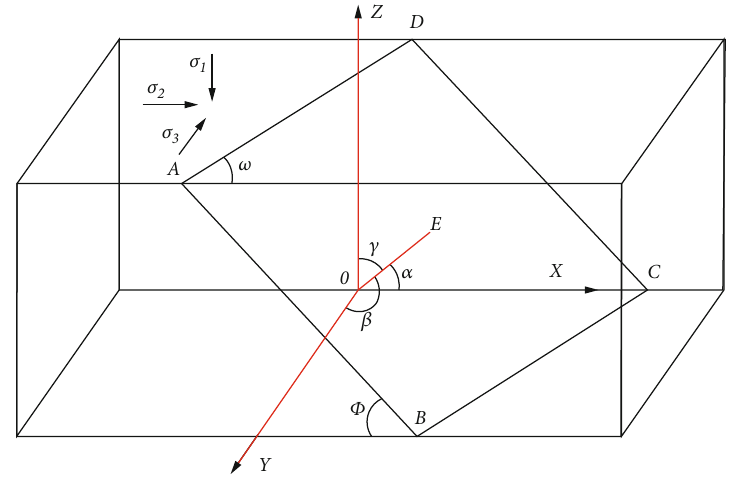
Figure 1: Mechanical model of fault